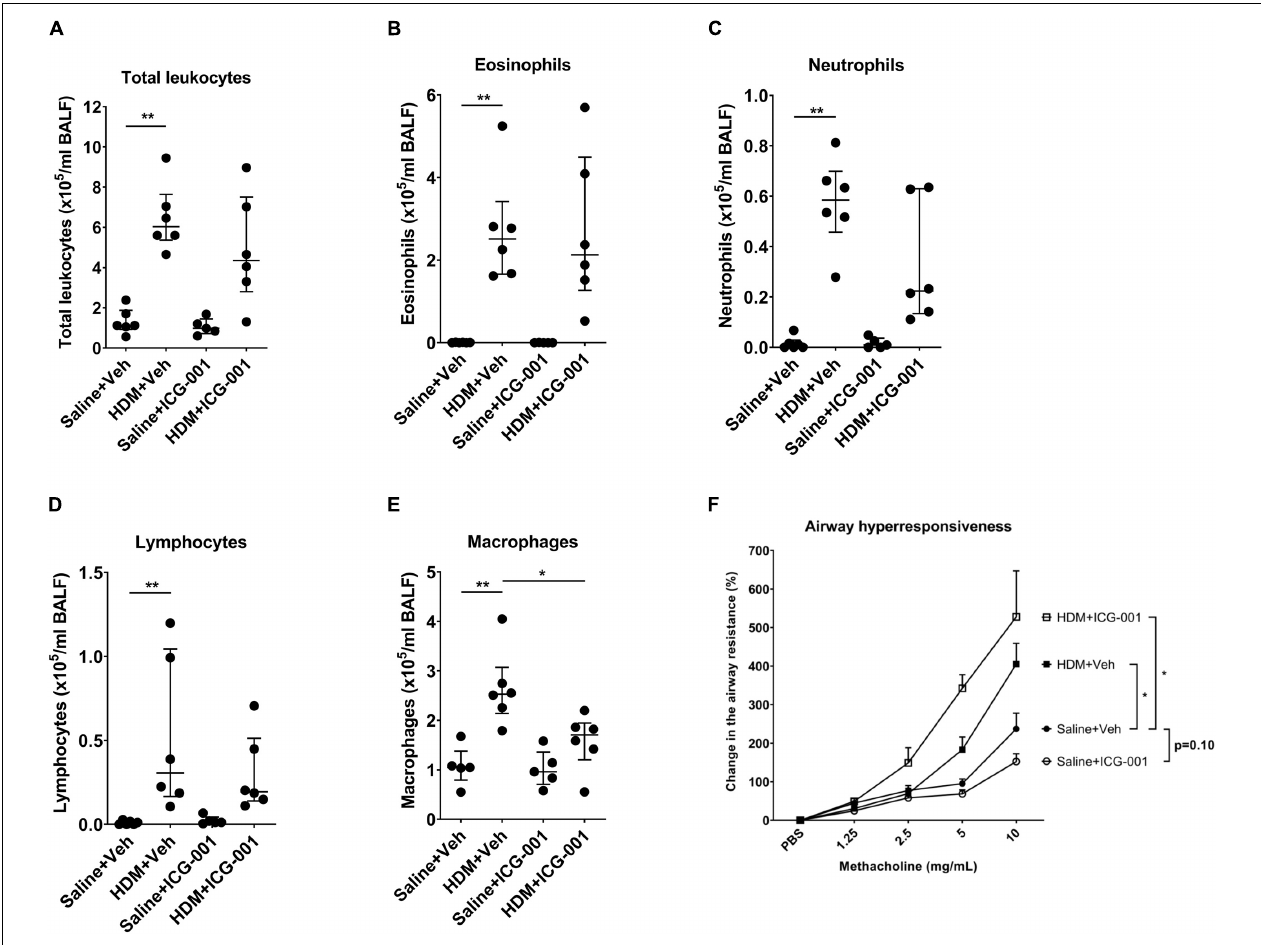
FIGURE 3 | ICG-001 inhibits HDM-induced infiltration of macrophages but does not influence HDM-induced AHR. Numbers of (A) total leukocytes ( n = 5–6), (B) eosinophils ( n = 5–6), (C) neutrophils ( n = 5–6), (D) lymphocytes ( n = 5–6), and (E) macrophages ( n = 5–6) present in BAL fluid of mice. Data is presented as median ± IQR; n = 5–6, * p < 0.05, ** p < 0.01, Mann–Whitney U test. (F) Change in the methacholine-induced airway resistance (%) in mice following exposure to HDM and treated with ICG-001 or vehicle-treated controls. Data is presented as median ± IQR; n = 6, * p < 0.05, two-way